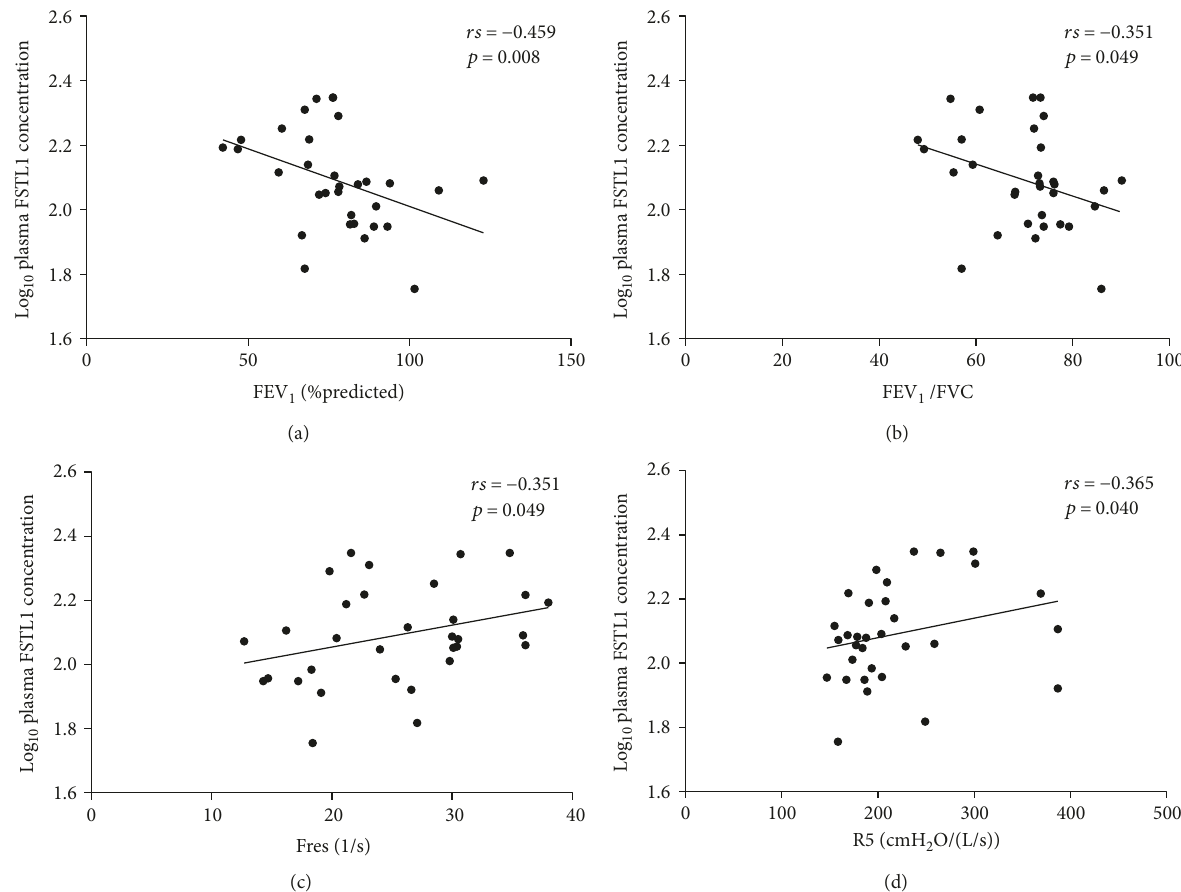
Figure 2: Correlation between plasma log FSTL1 levels and spirometric and IOS parameters. Correlations between plasma log 10 and (a) FEV (%predicted), (b) FEV /FVC, (c) Fres, and (d) R5. Correlations were determined by Spearman rank correlation analysis. 1 1